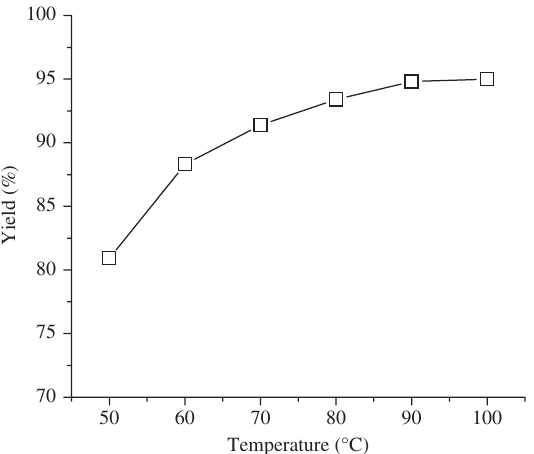
Figure 4 Yield of methyl caprylate by esterification of caprylic acid with methanol over (Tshx)(HSO